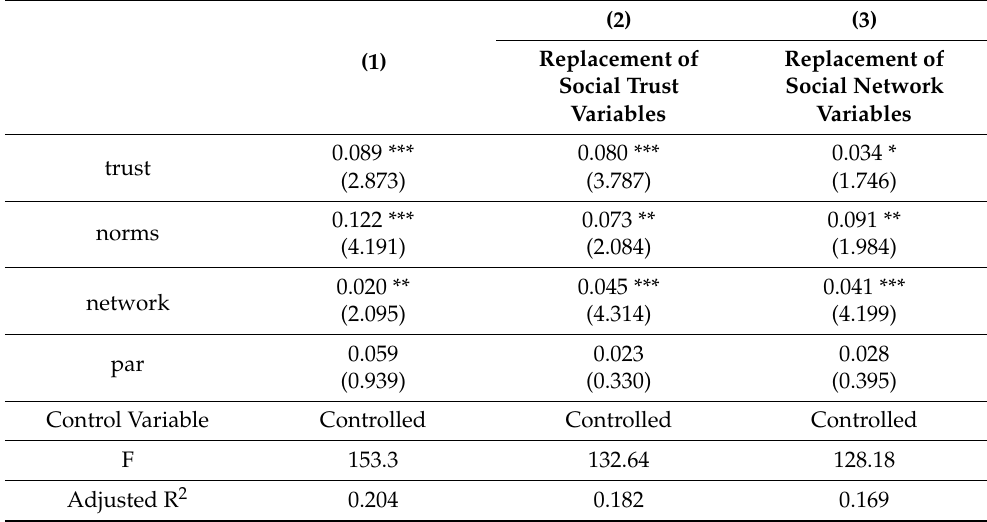
Table 8. Mechanism analysis ( N =